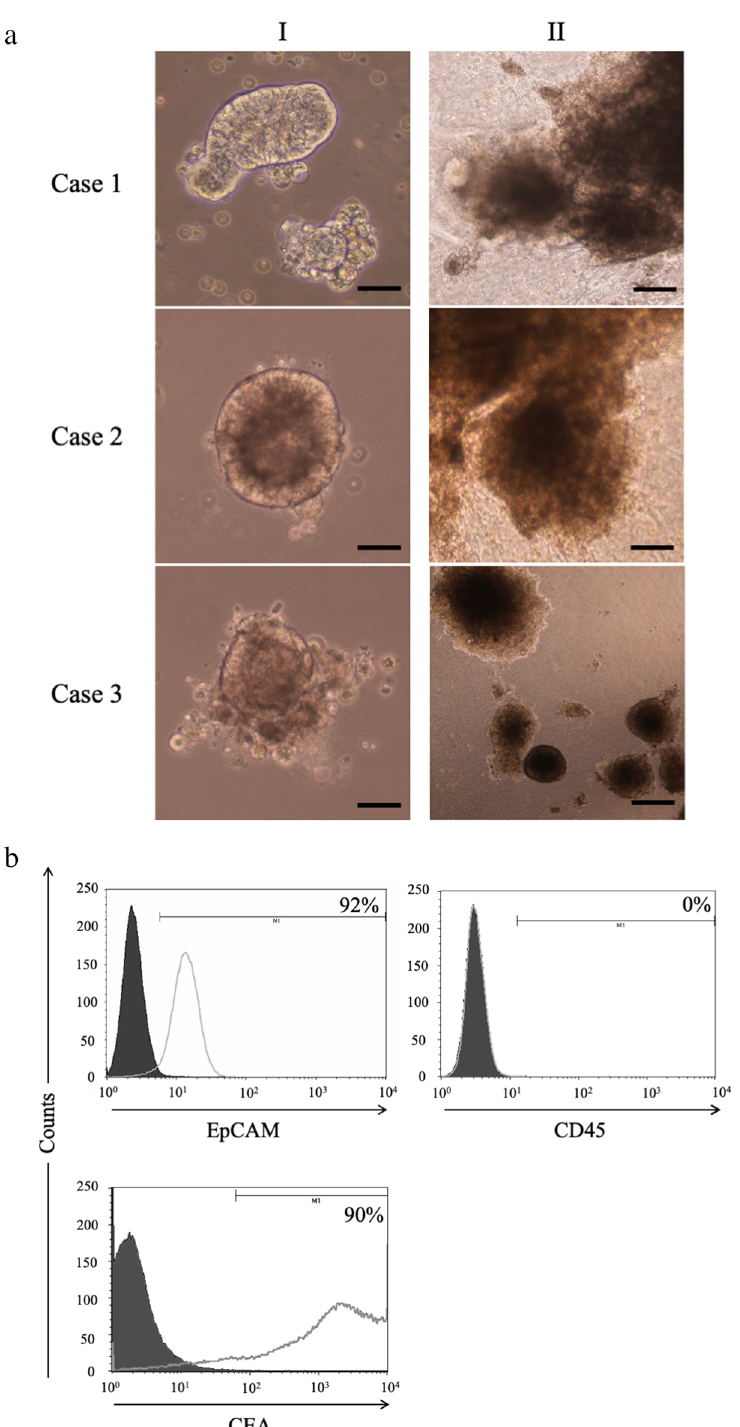
Figure 2. Establishment of Autologous CTOSs. ( a ) Formation of CTOSs from colorectal cancer tissues of three patients. Phase contrast images of organoid fraction: I, suspension culture; II, 3D culture. Scale bar = I, 100 μm; II, 40 μm. ( b ) Expression of EpCAM, CD45, and CEA in the CTOSs established from Case 1. Black-filled histograms represent the isotype-matched control. Gray lines highlight the staining results of EpCAM, CD45, and